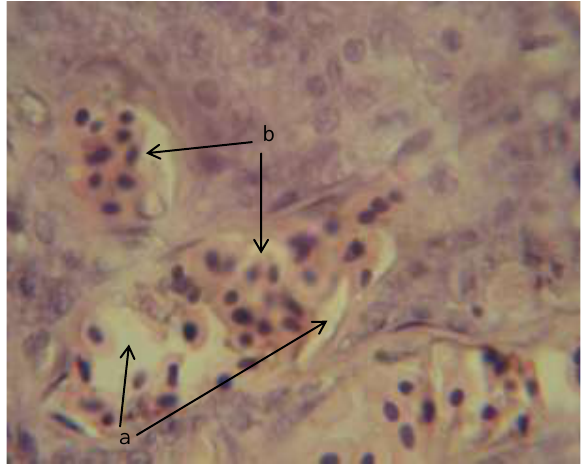
Figure 12: Histological section of gill Cyprinus carpio infected with Branchiomyces spp. , revealing (a) hyphae; (b) hyphae loaded with progeny of plasmodia (sporonts) at various stages of differentiation (arrow: thin-walled sporonts, or 'daughter' plasmodia). H & E 1000 X.